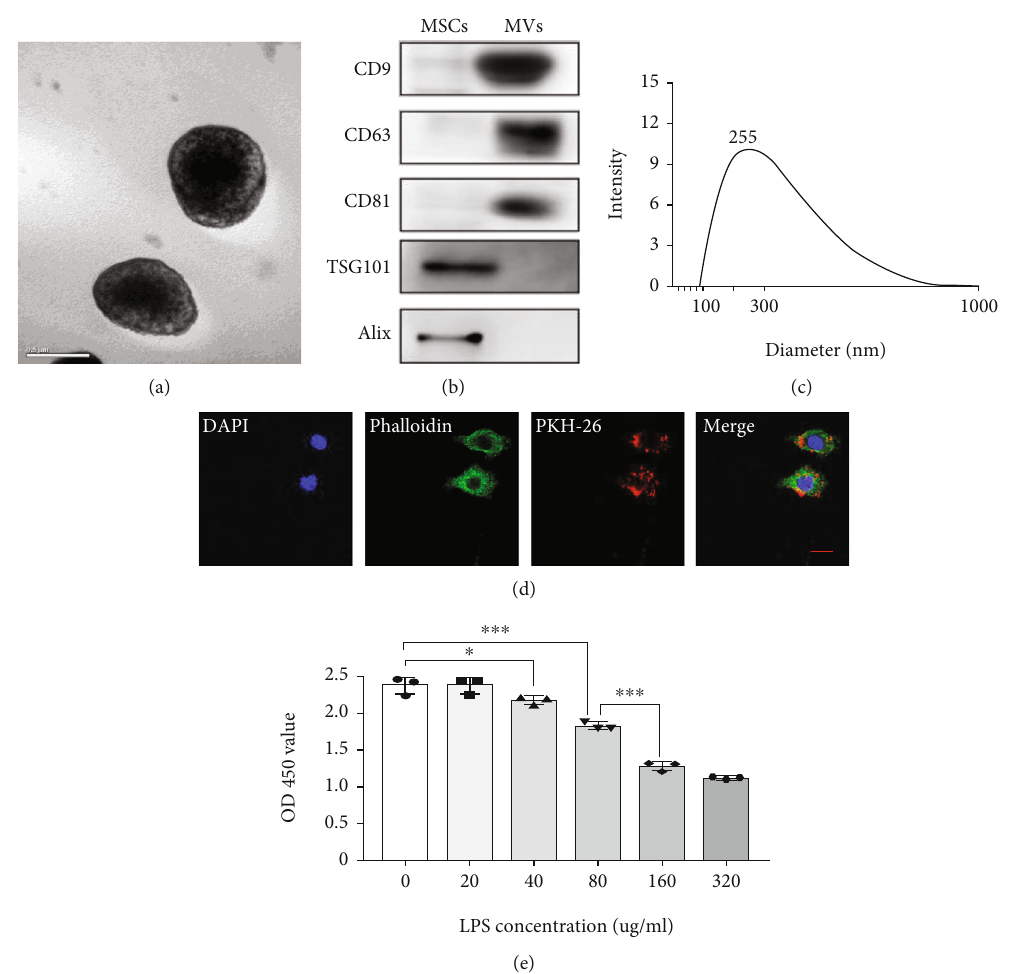
Figure 3: Characterization of hUCMSC-derived MVs. (a) Representative images of transmission electron microscopy (TEM) for MVs derived from hUCMSCs, scalebar = 500 nm. (b) Detection of MV-speci fi c biomarkers for both analyzed MVs and whole-cell lysates by western blot. (c) Nanoparticle tracking analysis (NTA) measurement of the mean size of MVs. (d) Representative images showing the colocalization of phalloidin immunostaining (green) with internalized MVs (red), scalebar = 50 μ m. (e) MLE-12 viability after exposure to di ff erent concentrations of LPS in vitro ( N = 3 , ANOVA, ∗ P < 0 : 05 and ∗∗∗ P < 0 : 001